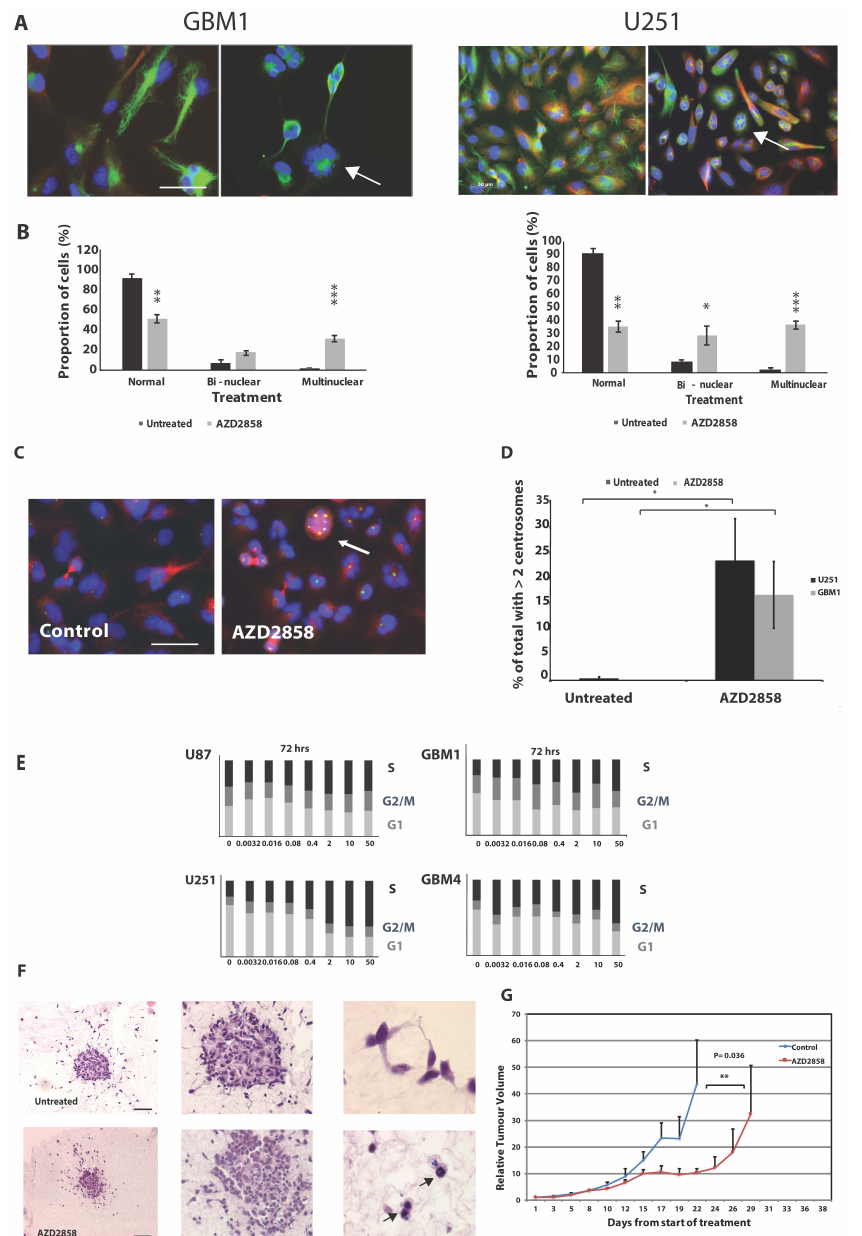
Figure 2. Treatment with AZD2858 induces a multinuclear phenotype in patient-derived stem cell-like lines and established glioma cell lines. ( A ) Cell lines were treated with AZD2858 at 1 µ M concentration and allowed to incubate for 72 h. They were then fixed with 100% methanol and stained with anti-tubulin antibody (green) and DAPI (blue). Representative images by confocal microscopy are shown for the cell line GBM1 and U251. The arrow indicates multinucleation. Scale bar = 20 µ m. ( B ) Immunofluorescence images were used for counting and quantification of cells for the presence of two (bi) or more (multi) nuclei per cell. At least 200 cells/cell line were scored. Results are shown for the patient-derived stem cell-like cell line GBM1 and the established cell line U251. ( C ) Cell lines were treated with AZD2858 at 1 µ M concentration and allowed to incubate for 72 h. They were then fixed with 100% methanol and stained with anti-pericentrin antibody (green) and DAPI (blue). Representative images by confocal microscopy are shown for the cell line U251. The arrow indicates the presence of several centrosomes. Scale bar = 20 µ m. ( D ) Immunofluorescence images were used for counting and quantification of cells for the presence of two or more centrosomes/cell. At least 200 cells/cell line were scored. ( E ) Established (U87, U251) and patient-derived stem cell-like cell